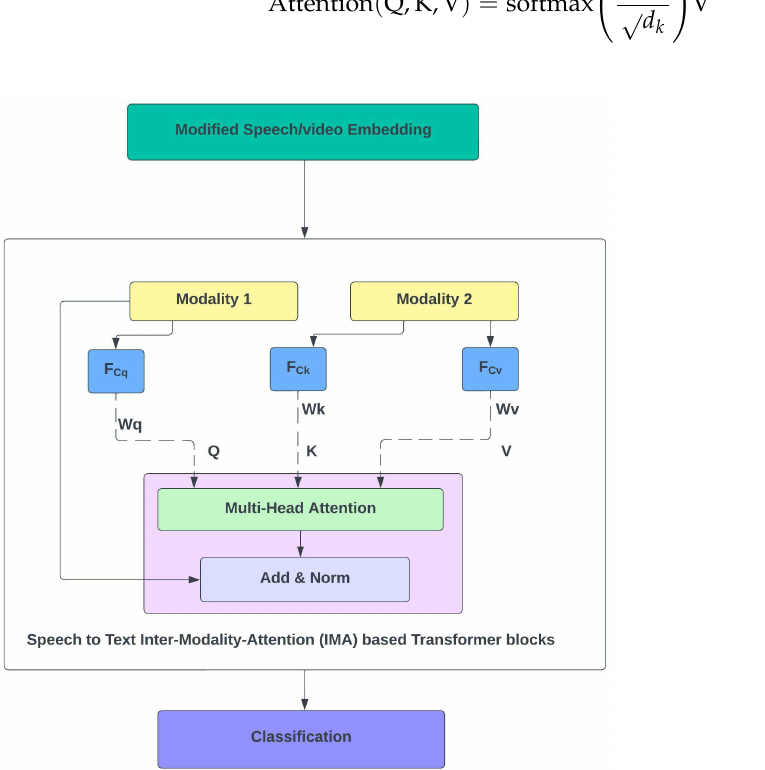
Figure 4. The process of classifying the emotions using multi-head-attention- and inter-modality- attention-based